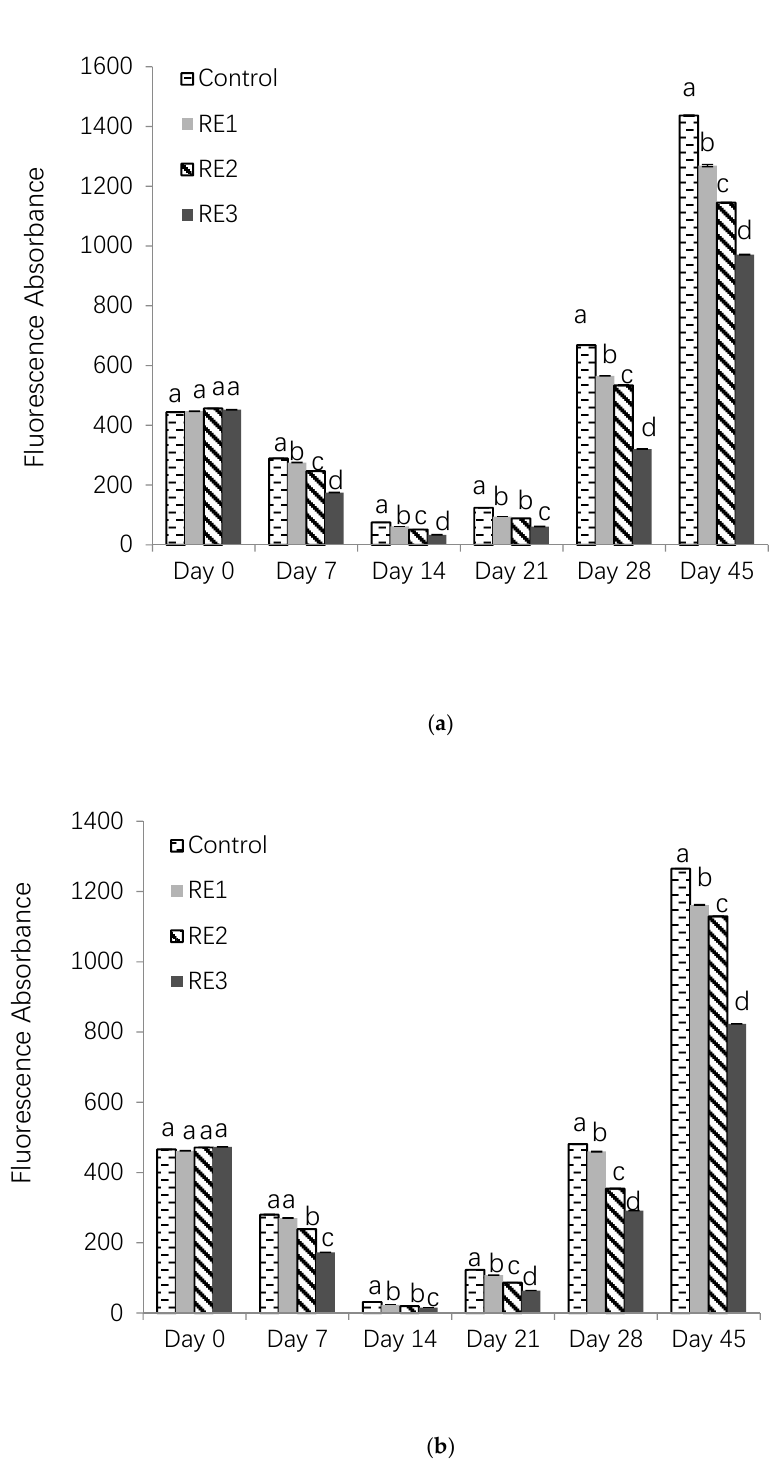
Figure 2. Fluorescence absorbances of AGEs in control and rosemary extract treatments under ( a ) wa 0.75 and ( b ) wa 0.56 conditions (RE1, 1%; RE2, 2%; RE3, 4%).